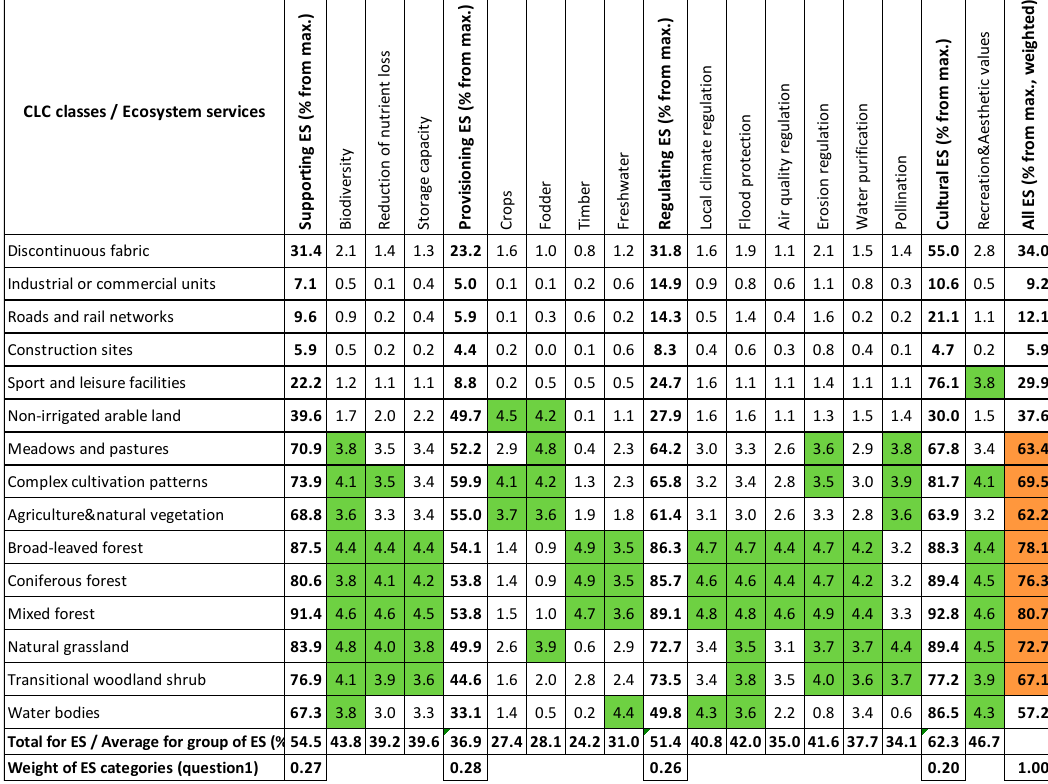
Figure 3. Matrix of experts’ judgment of land cover types across selected ecosystem services (the values 3.5 and higher per particular CORINE land cover (CLC) type and the service are highlighted in green, overall ecosystem services (ES) provision per CLC type above 60% is highlighted in orange, the average values, the sums and the weights are in bold and they are explained in Section 2.3).